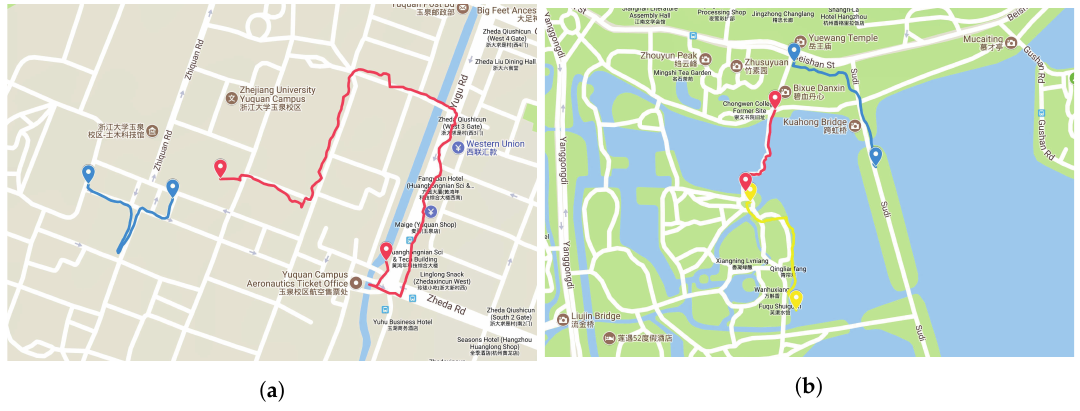
Figure 20. The trajectory of experiments carried out by visually impaired volunteers in: ( a ) the Yuquan Campus of Zhejiang University; and ( b ) the landscape area of the West